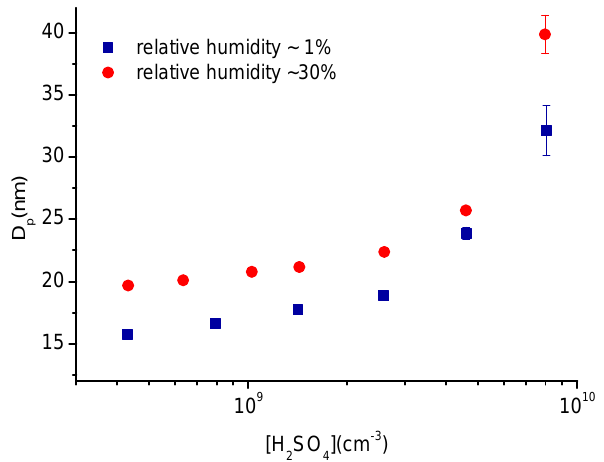
Figure 7. The growth factors as a function of the H 2 SO 4 concen- tration at T = 293 and T = 303K at different residence